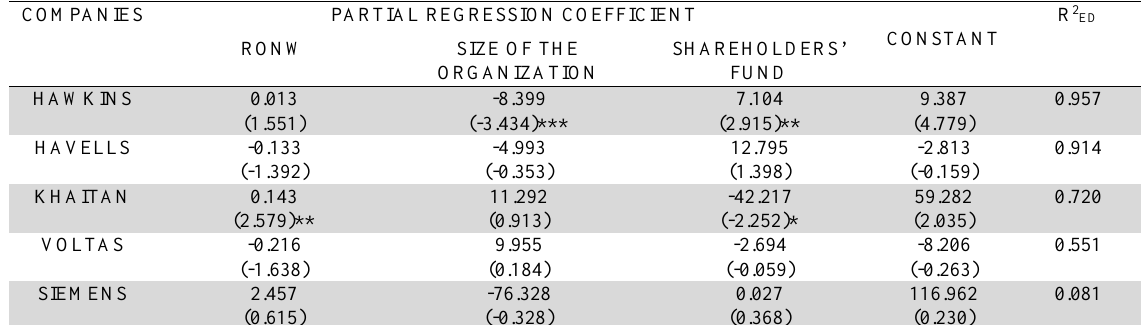
Analysis of Multiple Regression of CCC on RONW, Size of Org. and shareholders’ Fund of the Selected Companies of Consumer Durable